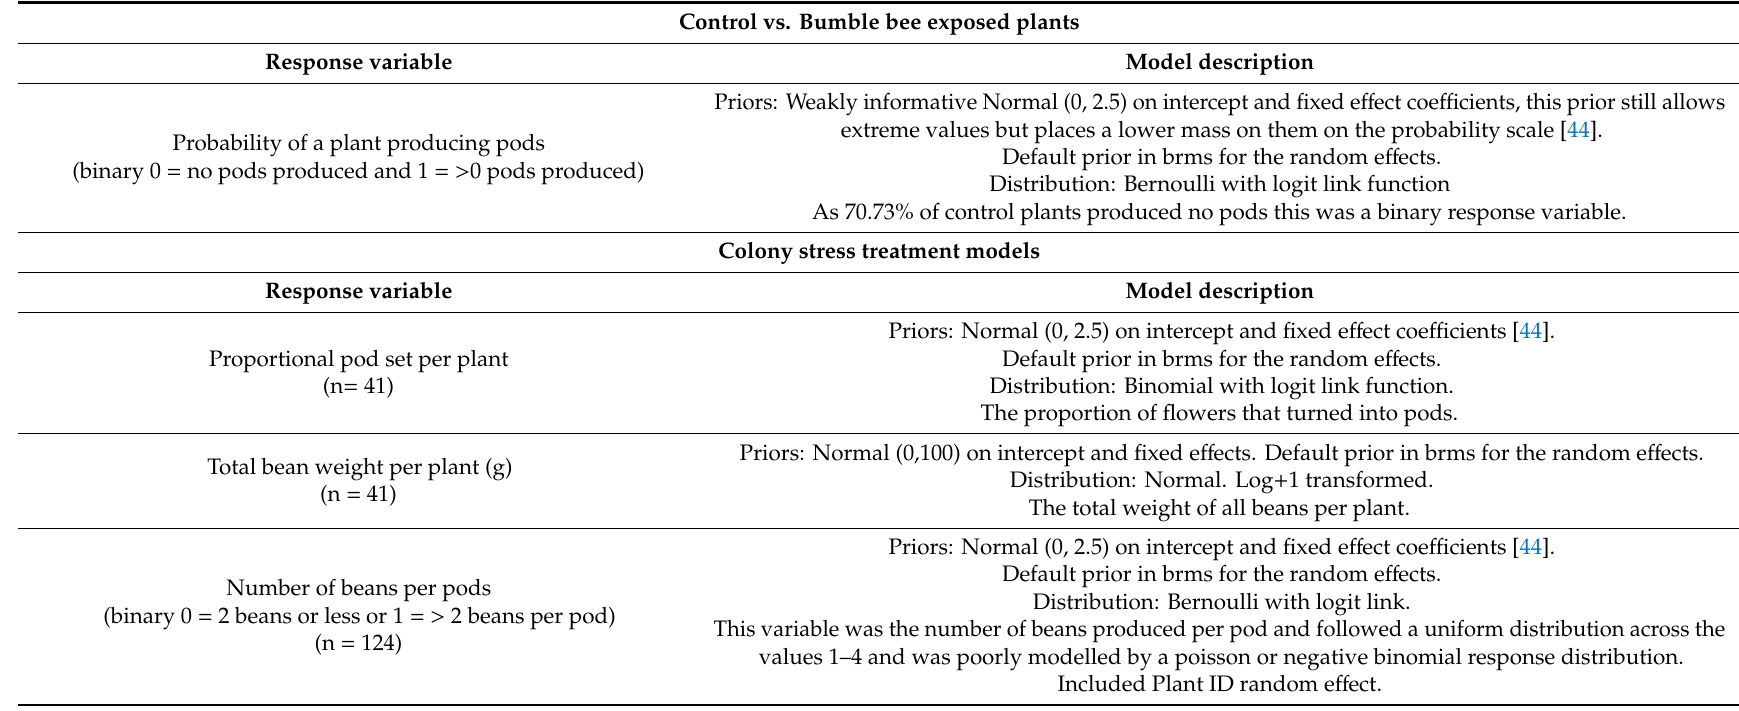
Table 2. Faba bean ( Vicia faba ) yield parameters and the model structure used to determine the e ff ects of Heat and Insecticide (clothianidin) stress on Bombus terrestris pollination services. Control plants were not exposed to bumble bees. Colony stress treatments were Heat (25 ◦ C or 31 ◦ C) and Insecticide (40% sucrose solution or 40% sucrose solution including 5 ng g -1 w / w of clothianidin). Each level of Heat treatment was crossed with each level of Insecticide for the colony stress treatment models only. Priors are expressed as Normal ( µ , σ